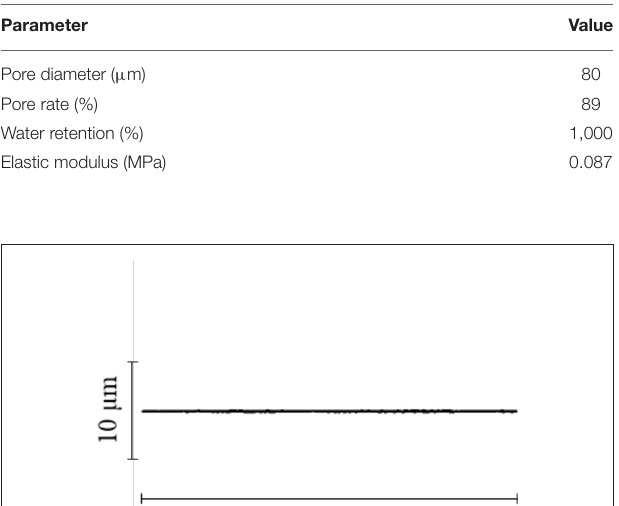
TABLE 1 | Parameters of the PVF seal.